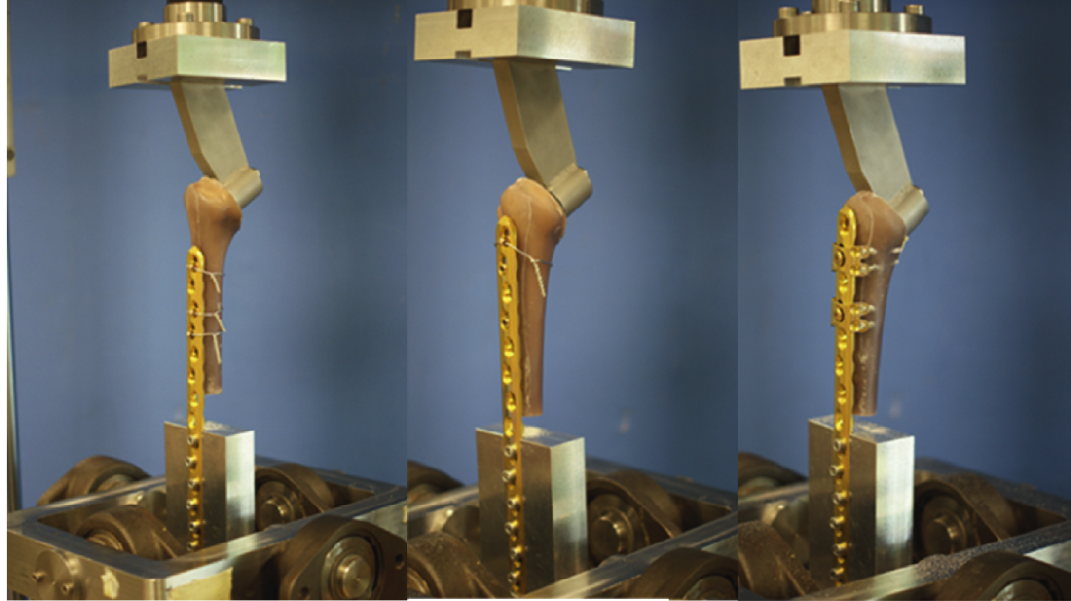
Figure 3: Humerus-LCP construct mounted on the servo-hydraulic material testing